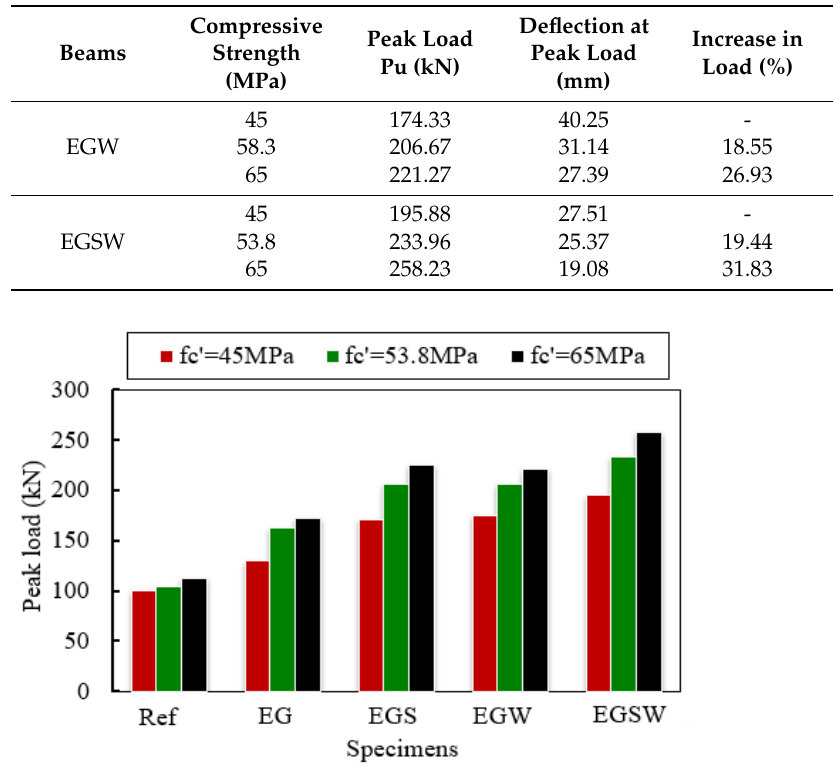
Table 10. Effect of the GFRP tensile strength.